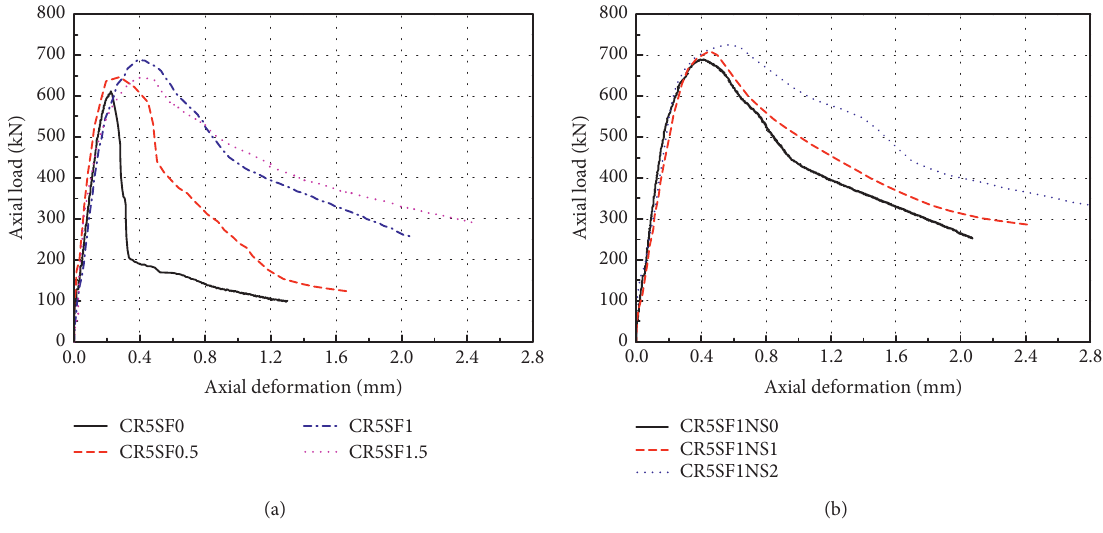
Figure 8: Load-deformation curves of SFNS-CRC with different (a) ]